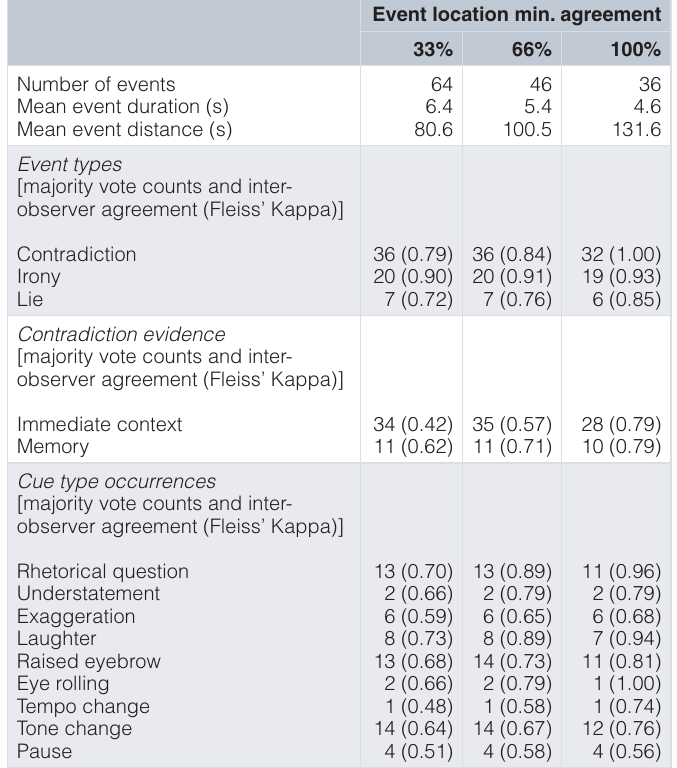
Table 2. Annotation inter-observer agreement statistics. Number of events and categorization agreement are presented for three levels of inter-observer agreement on the temporal location and the performing movie character. The number of events for any particular event property are determined by majority vote across observers, i.e. an event is counted when more observers indicate the presence of a property than its absence. Exhaustive technical detail on the statistical analysis can be found in the descriptive_stats.py Python